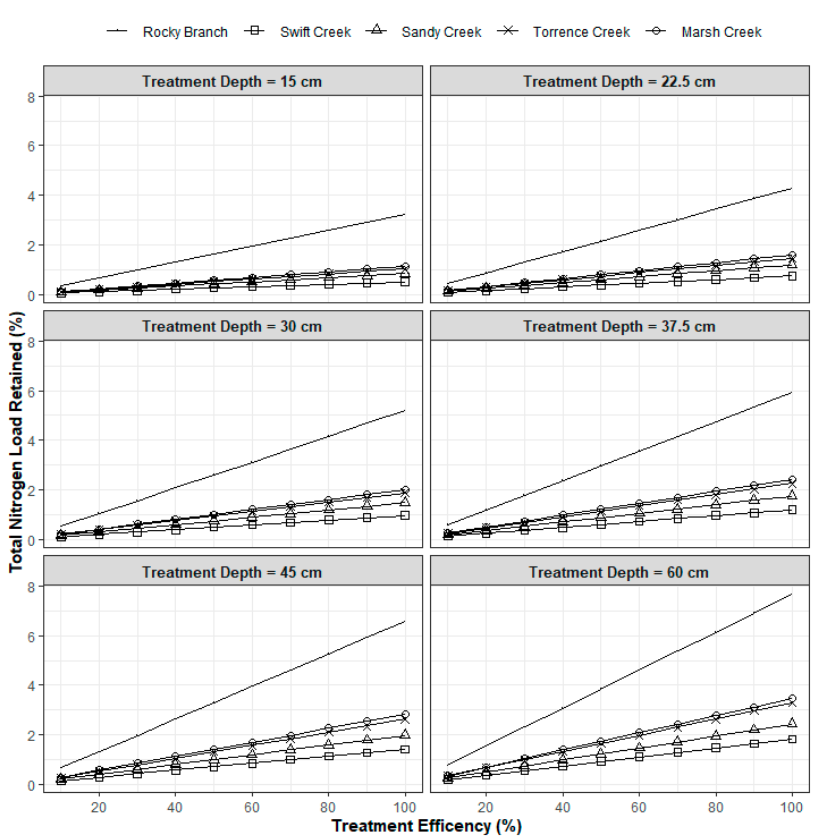
Figure 6. Comparison of percent total nitrogen (TN) retention / removal estimates based on a range of treatment efficiencies and treatment depths.